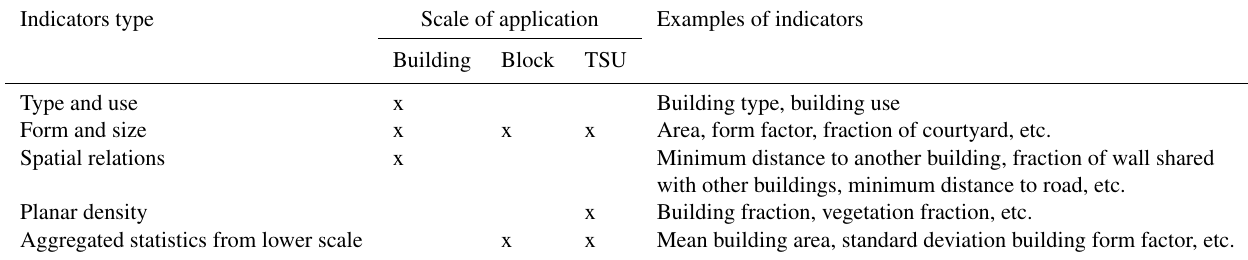
Table 4. Types of spatial indicators used to define the main characteristics of each unit scale.